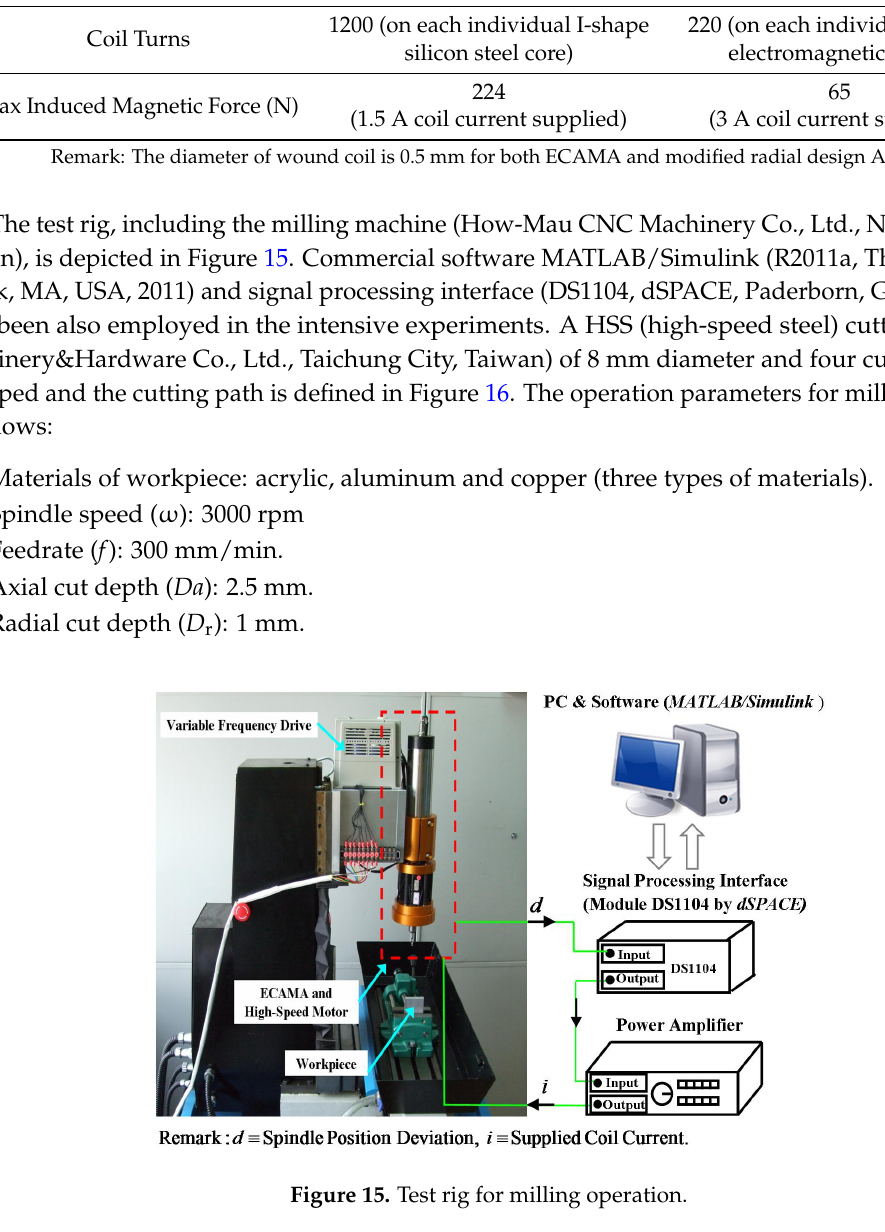
Figure 16. Cutting path of milling tests. The realistic trajectories of spindle position deviation in X - Y plane for three kinds of materials are shown in Figures 17–19, respectively. The maximum spindle position deviations for the three different kinds of workpieces are similar, but the spindle dynamics under acrylic cutting is much more complex than those under other materials. Since acrylic is brittle, the variation of cutting force is possibly more drastic than that of metal cutting. Therefore, the compensative force by the ECAMA during acrylic cutting should be tuned rapidly according to the cutting condition. In addition, though the trajectories of spindle position deviation corresponding to aluminum and copper are similar, the spindle position deviation for copper cutting is smoother than that for aluminum cutting, due to different metal properties ( i.e. , copper is more ductile). The photographs of the finished workpiece surface are shown in Figures 20–22. The resulting ridges on aluminum are more significant than those on acrylic and copper. The efficacy of the proposed FMRAC for spindle position regulation is verified by realistic milling.